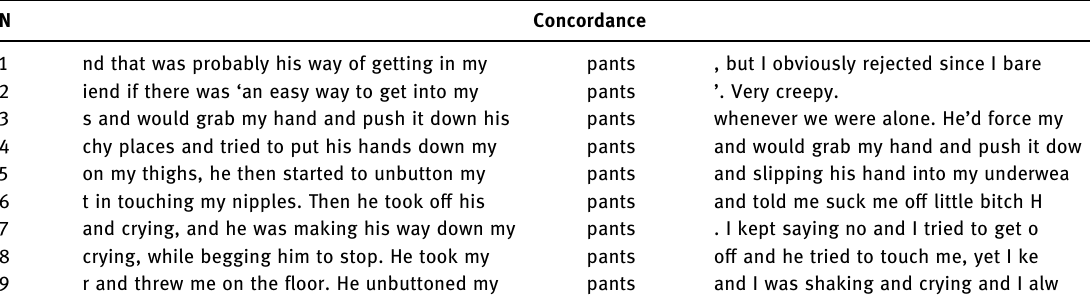
Table 44: Concordance lines for pants N Concordance